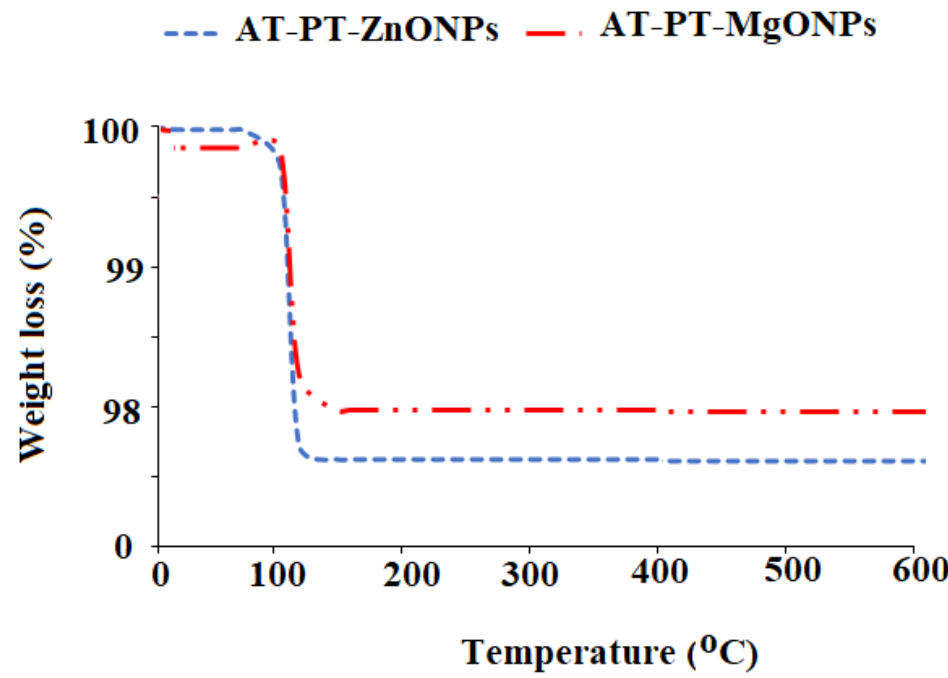
Figure 9. The thermal stability of the modified AT-PT-ZnONP and AT-PT-MgONP membranes measured by the TGA analysis.